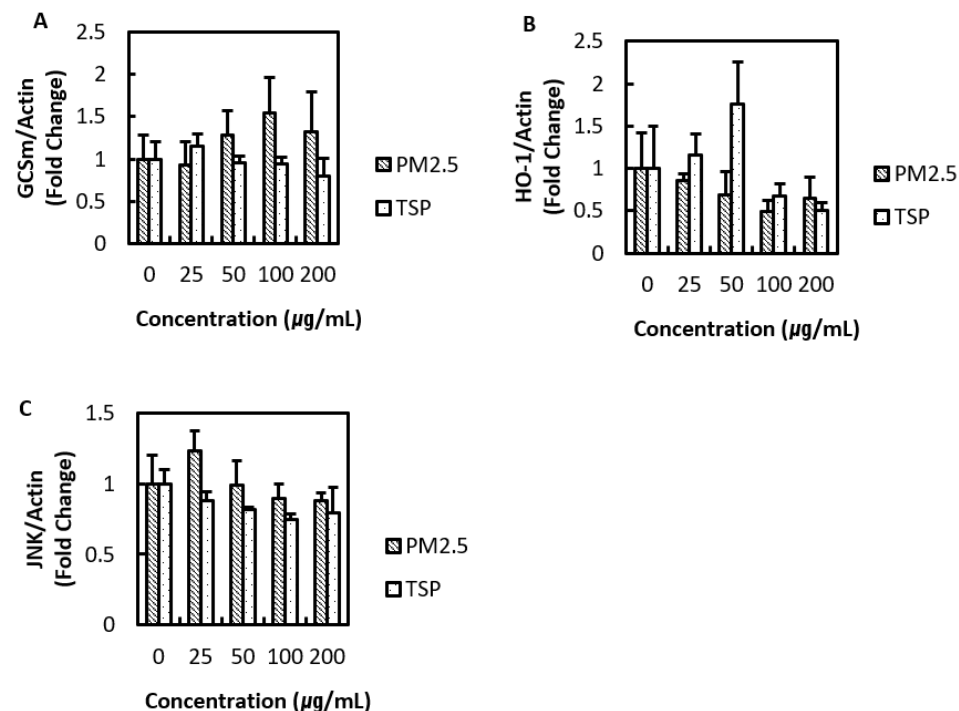
Figure 6. Effects of PM and TSP on the level of the glutamate-cysteine ligase modifier (GCSm), Heme oxygenase 1 (HO-1), and c-Jun N-terminal kinase (JNK). Protein expression of ( A ) GCSm, ( B ) HO-1, and ( C ) JNK were measured in A549 cells exposed to PM2.5 and TSP at 0, 25, 50, 100, and 200 µg/mL for 24 h.